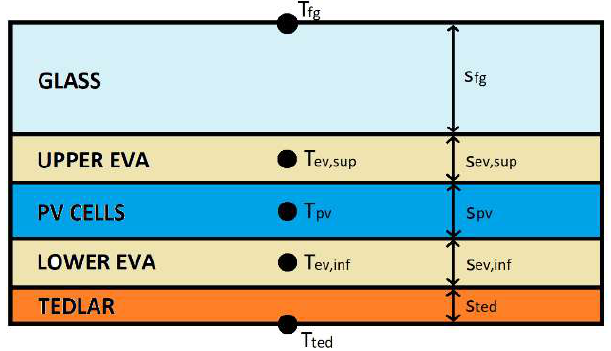
Figure 1. Stratigraphy of the PV panel and nodes. The nodes inside the panel exchange heat only by conduction with adjacent